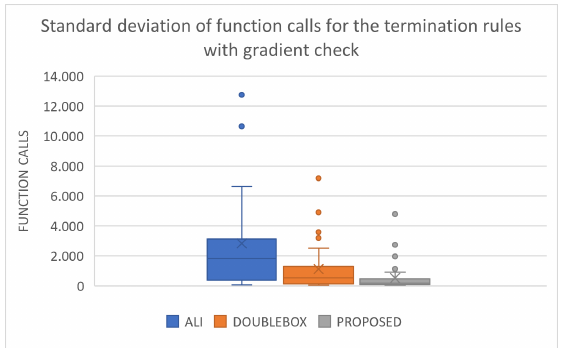
Figure 2. Standard deviation of function calls for the termination rules with the gradient check.